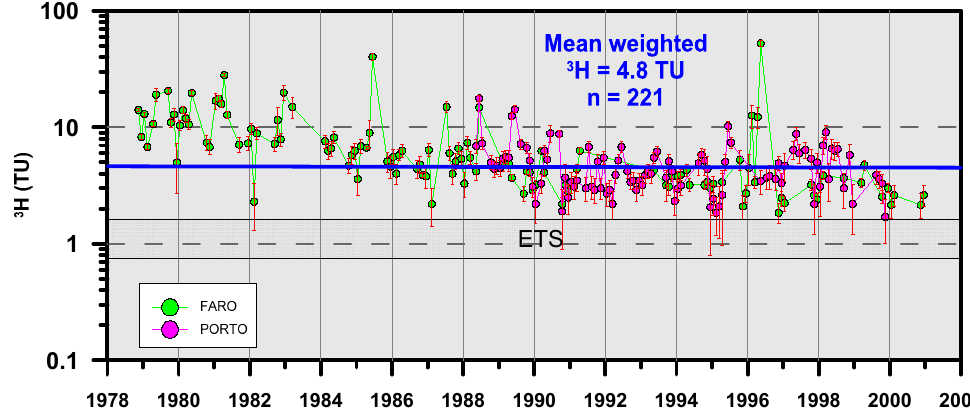
Figure 8. Monthly tritium values in rainwater from Faro and Porto stations which belong to the Global Network of Isotopes in Precipitation (GNIP) in comparison with tritium contents in ETS water samples. Source: IAEA/WMO (2022). Global Network of Isotopes in Precipitation. The GNIP Database. Accessible at: https://nucleus.iaea.org/wiser (accessed on 20 December 2022). The δ 13 C TDIC and 14 C values for RA2, AC3A and FCB water samples are reported in Table 3. The δ 13 C TDIC values are rather uniform, ranging from − 11.7‰ to − 7.51‰ with respect to the standard V-PDB, suggesting a similar origin with different contributions